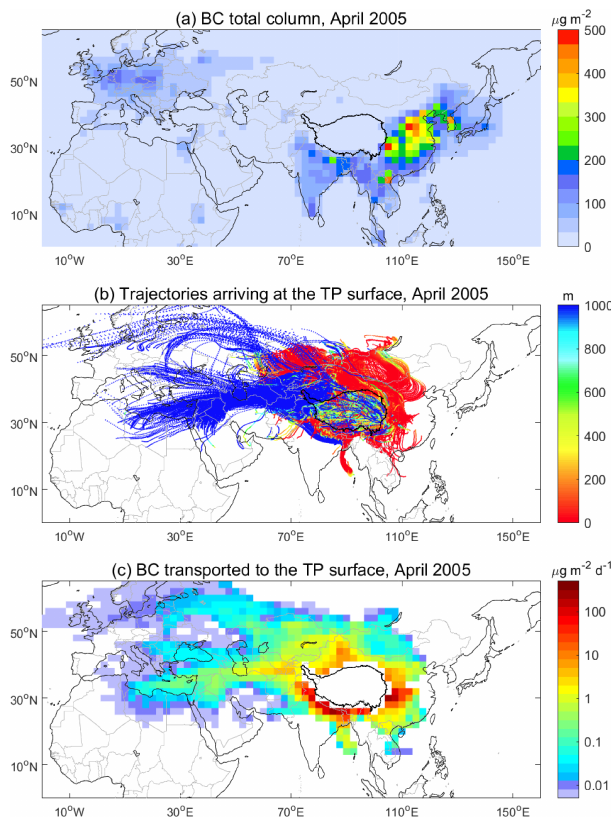
Figure 2. An example of estimated BC transport to the TP sur- face from non-local regions in April 2005. (a) BC total col- umn (µgm − 2 ); (b) 7d backward trajectories (in metres above the ground) arriving at the TP surface; (c) the amount of BC transported to the TP surface from non-local regions (µgm − 2 d − 1 ). The dark black line encloses the domain of the